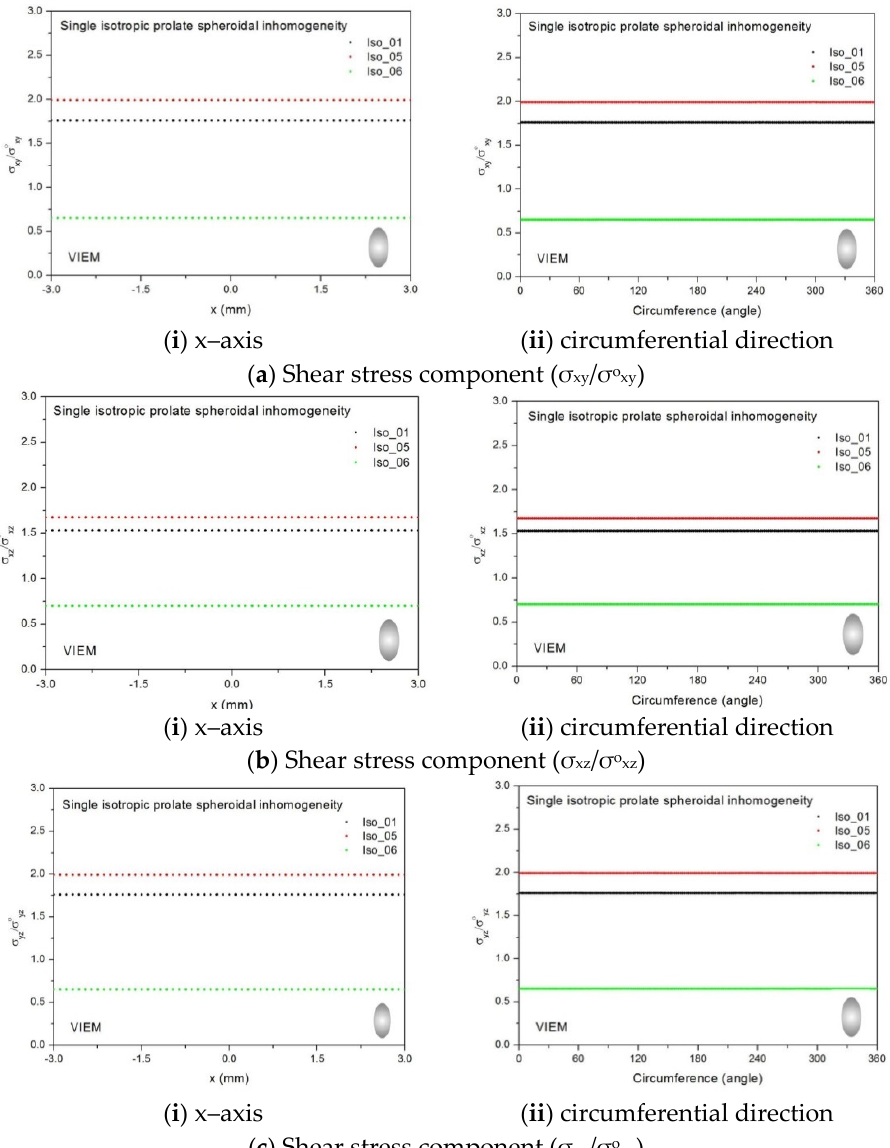
Figure 24. VIEM results for the normalized shear stress components ( a ) σ xy / σ o xy , ( b ) σ xz / σ o xz and ( c ) σ yz / σ o yz along ( i ) the x–axis inside and ( ii ) the circumferential direction of the isotropic prolate spheroidal inclusions (Iso_01, Iso_05 and Iso_06) with a/b = c/b = 0.5 (b = 6 mm) under remote shear loading ( σ oxy , σ oxz and σ oyz ).